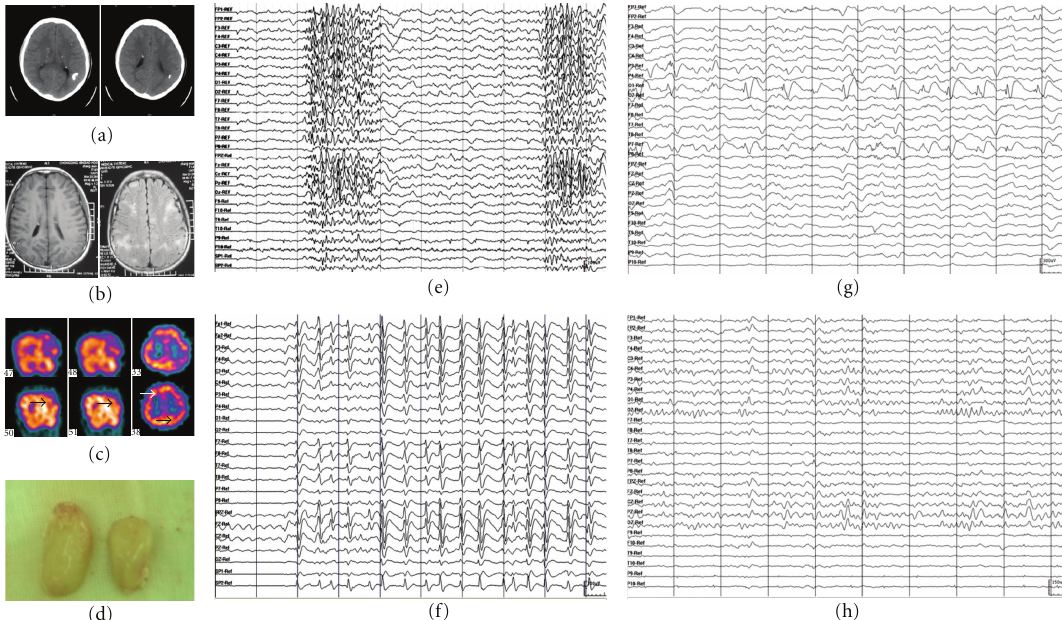
Figure 3: Clinical data of a patient with tuberous sclerosis. (a) CT scan showing calcification of the cortex and subependymal zone. (b) MRI showing subependymal zone tubers and cortex tubers. (c) Interictal (upper part) and ictal (lower part) SPECT results. Arrows point to interictal hypoperfusion and ictal hyperperfusion of the right frontal epileptic focus and left occipital epileptic focus. (d) Resected cortex tubers in operation. (e) EEG showing PFA. (f) EEG showing SSW. (g) EEG showing epileptiform discharges during a partial seizure (left occipital lobe). (h) Postoperative EEG. Data were from patient no.: 14 in Tables 1 and